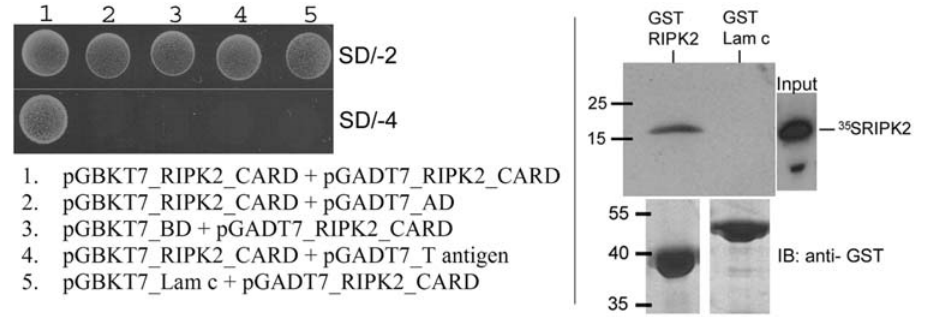
Figure 3. RIPK2 CARD forms homodimers/-oligomers. Left panel , Yeast two-hybrid analysis revealed that RIPK2 CARD (residues 427–527) forms homodimers/-oligomers (column 1 on SD/-4). Lamin c (Lam c) was used as control (column 5). Right panel , GST pull down assay. Specific binding of 35 S-labeled RIPK2 CARD (residues 427–527) was observed to recombinant expressed GST-RIPK2 CARD (residues 427–527), whereas binding to GST- Lam c was not detected. SD/-2: SD/-Leu/-Trp, SD/-4: SD/-Ade/-His/-Leu/-Trp.